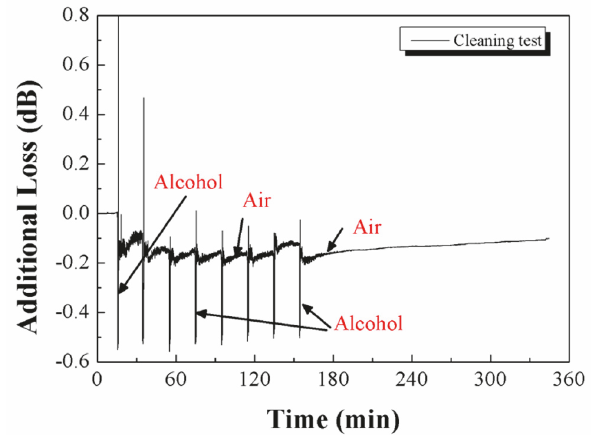
Figure 7: Repeatability of the response of an OMF sensor with a diameter of 5 𝜇 m when immersed in alcohol eight